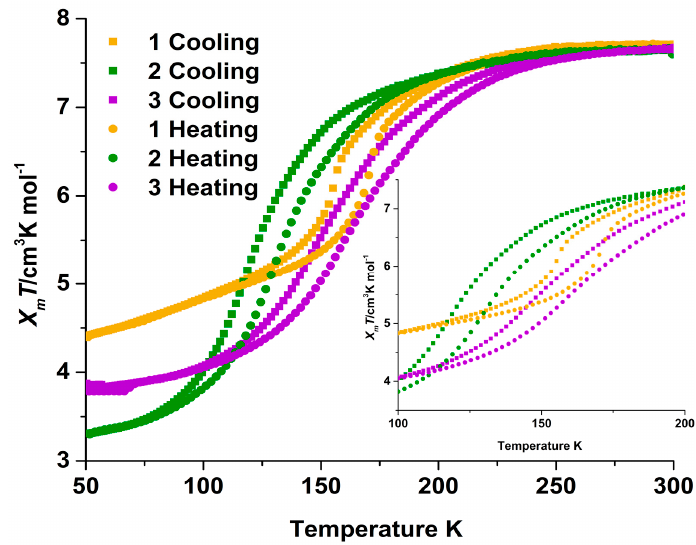
Figure 2. Magnetic susceptibility χ M T versus T plots for 1 – 3 , at a scan rate of 4 K/min over the temperature range of 50–300 K, in both the cooling (square) and heating (circle) modes. For clarity, the inset shows the spin transition between 100 and 200 K.